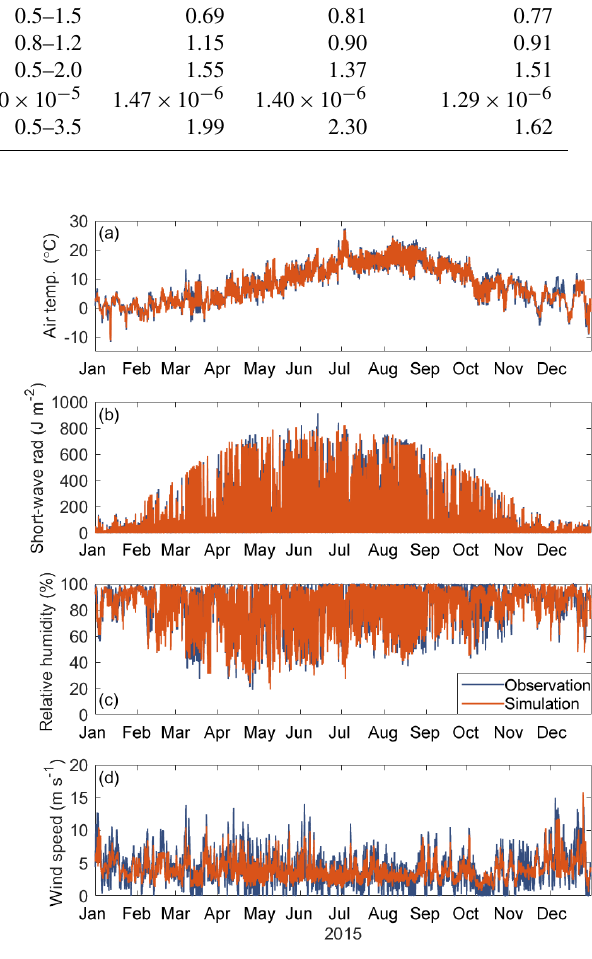
Figure 1. GRNN temporal disaggregation of meteorological forcing data. Observations vs simulations of (a) air temperature, (b) short- wave radiation, (c) relative humidity, and (d) wind speed for 2015 (validation data